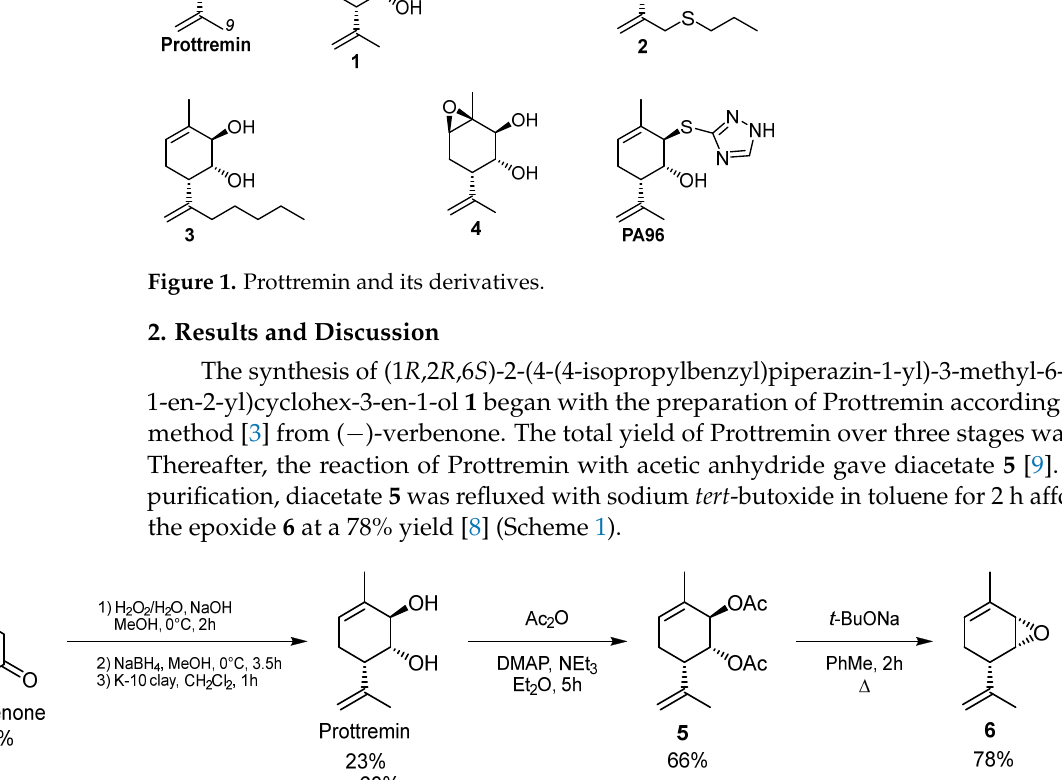
Figure 1. Prottremin and its derivatives.